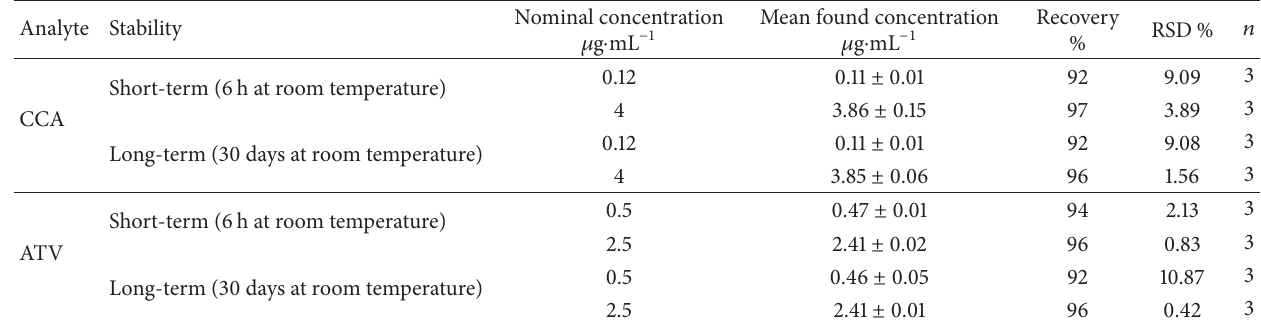
Table 3: Results of stability tests for clopidogrel carboxylic acid metabolite and